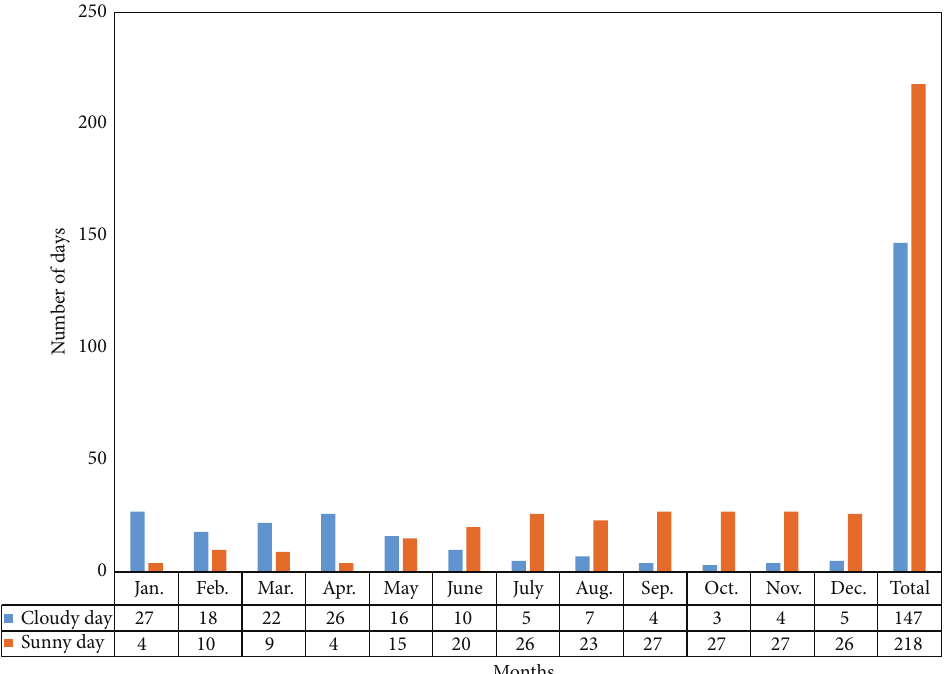
Figure 8: Monthly number of cloudy and sunny days for the year 2010.